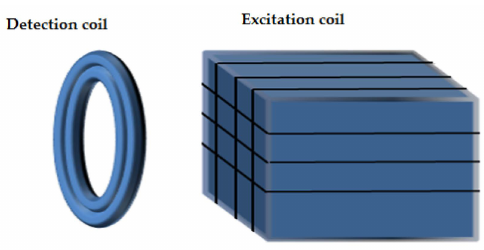
Figure 11. Two phase rotating field eddy current probe described by Birring